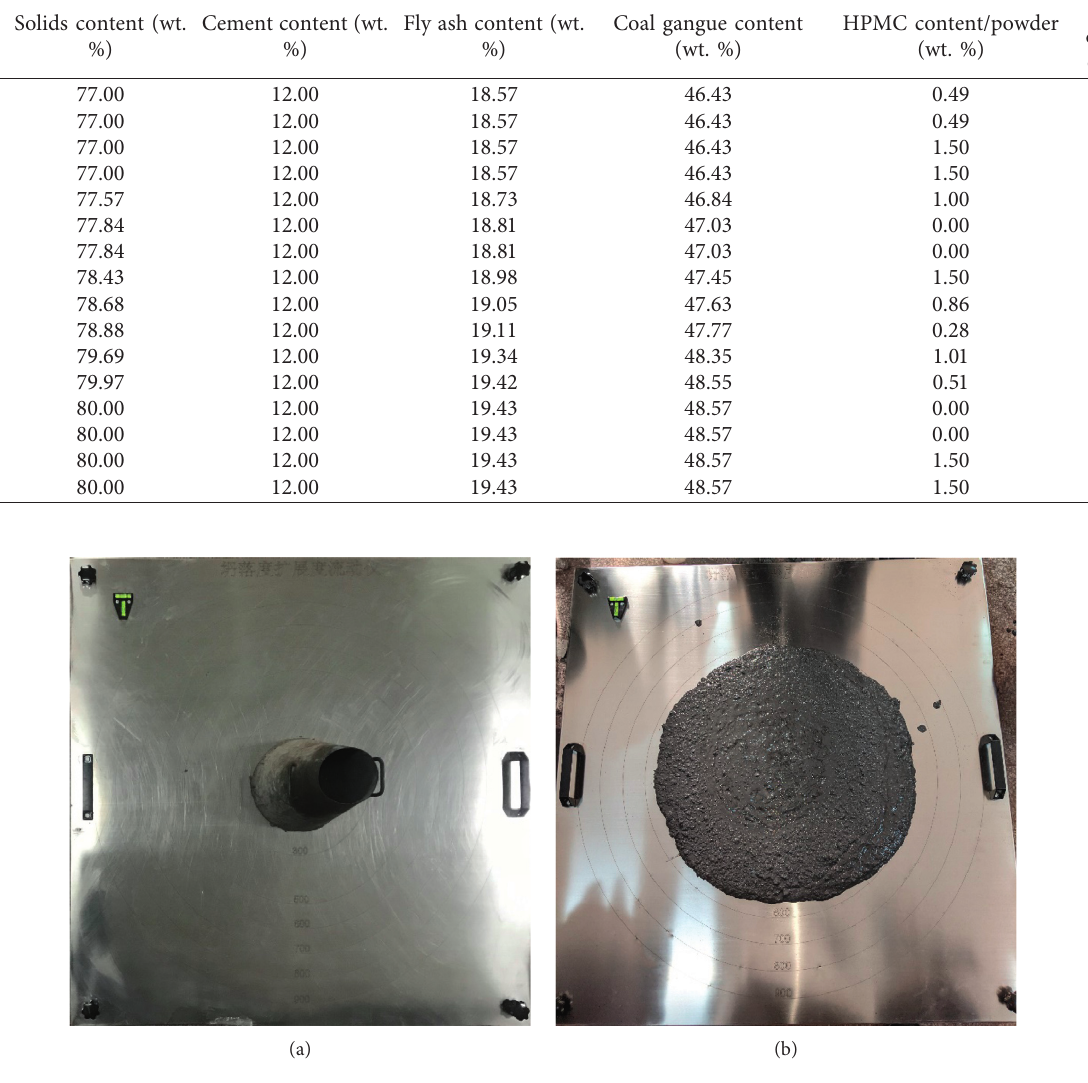
Figure 2: Graph of slump flow test. (a) Measuring device. (b) Slump flow